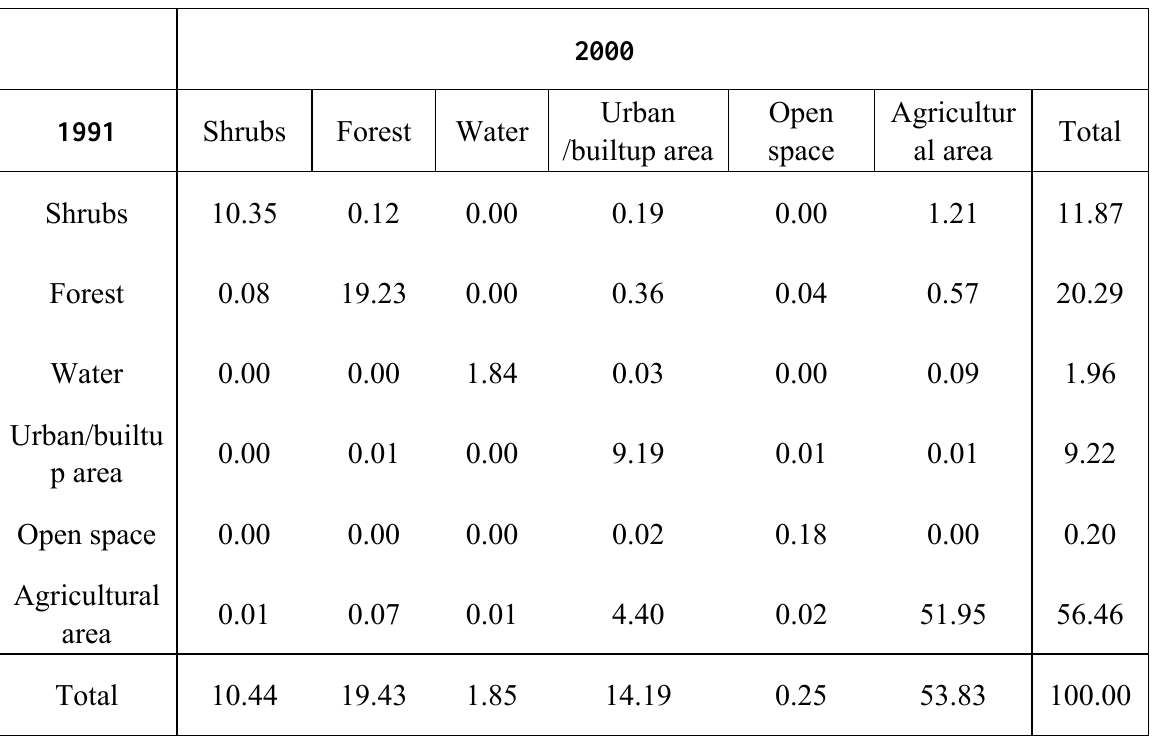
Table 6. Land use change in percentage (1991–2000).